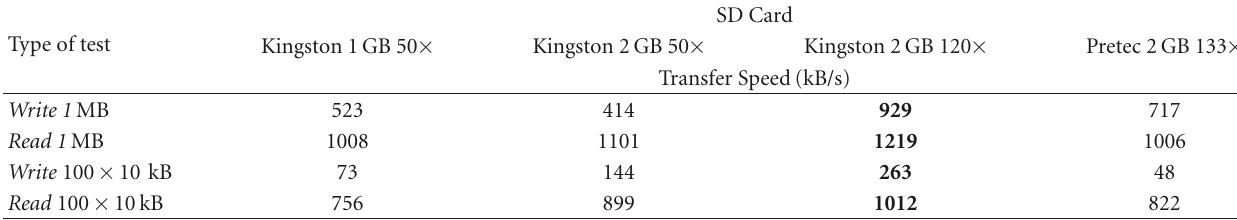
Table 3: Data transfer tests—SPB Benchmark software—SD Cards.